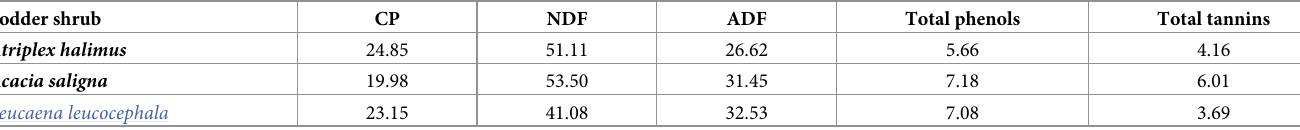
Table 1. Chemical composition (%) on dry matter basis of experimental fodder shrubs.